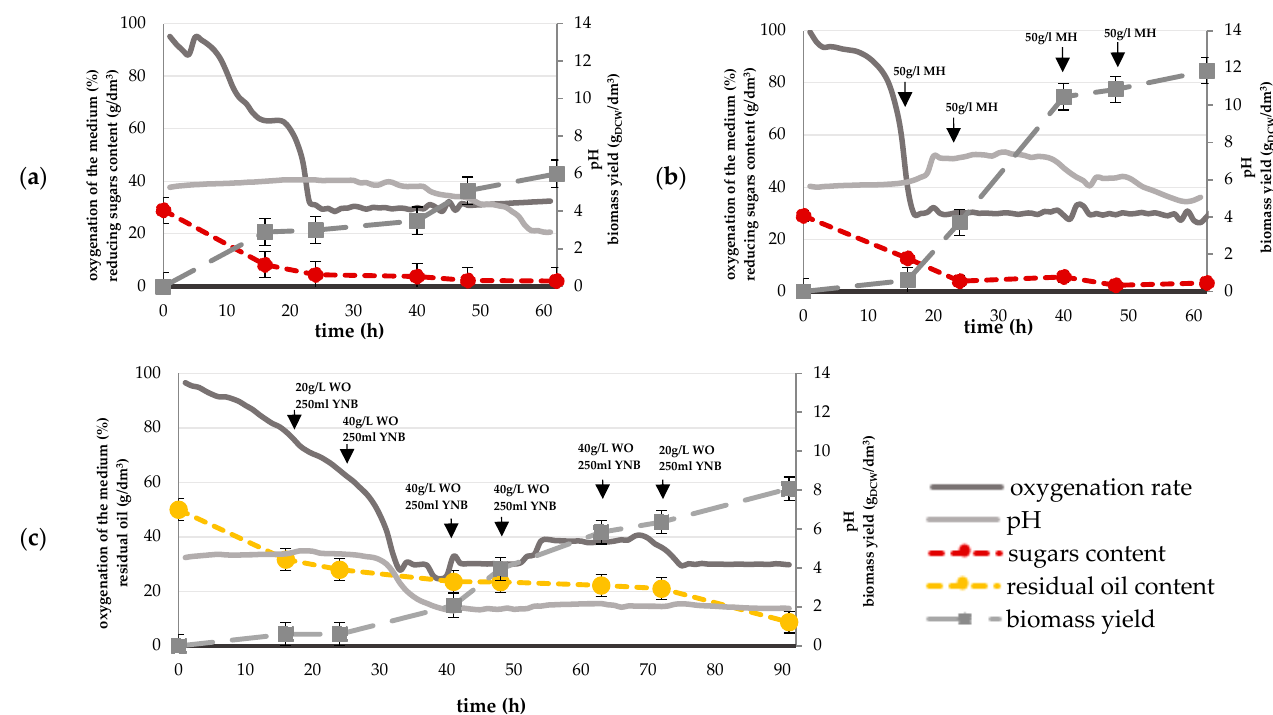
Figure 1. Changes in the oxygenation of the medium, pH, biomass yield of Y. lipolytica KKP 379 and content of reducing sugars in medium ( a ) M1-b and ( b ) M2-fb with hydrolyzed molasses hydrolysate (MH) as a hydrophilic carbon source and content of residual oil in ( c ) O1-fb medium with post-frying rapeseed oil (WO) as hydrophobic carbon source and supplemented with YNB